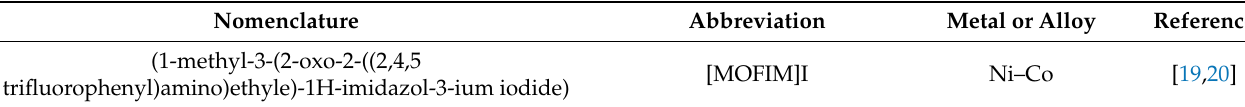
Table 1. Studies involving electrodeposition of metals and alloys with ILs in the last five